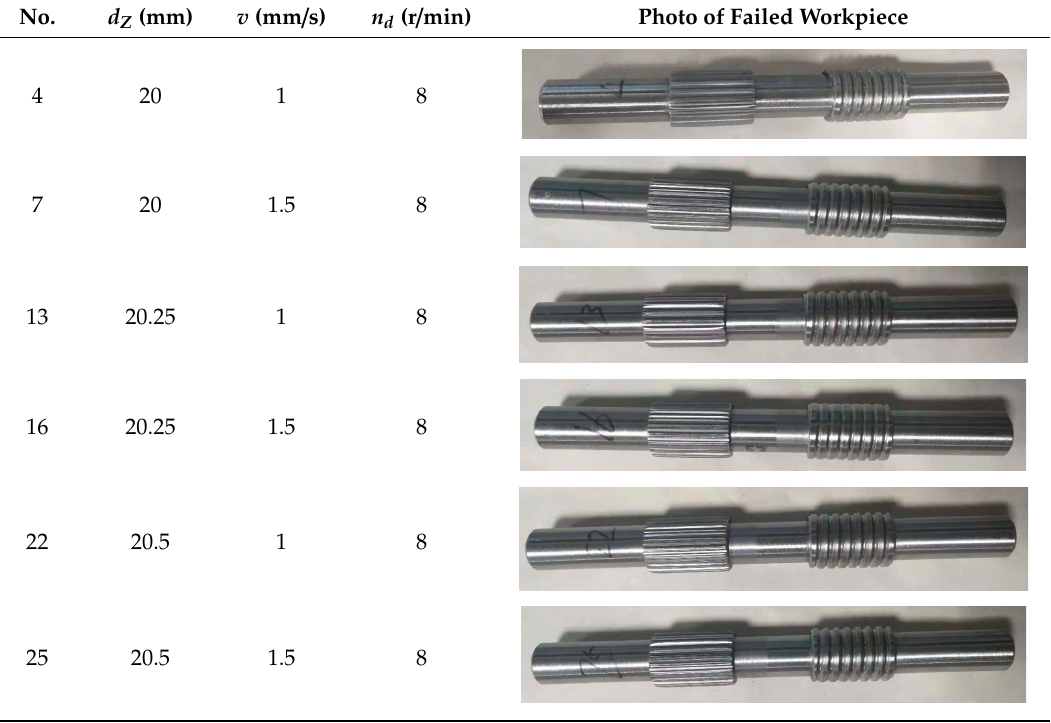
Table 4. Chemical constituents of AISI 1045 steel.